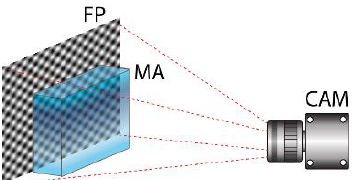
Fig. 3. Experimental arrangement of the fringe projection technique: FP – fringe pattern, MA – measured area (volume), CAM – camera with a lens .